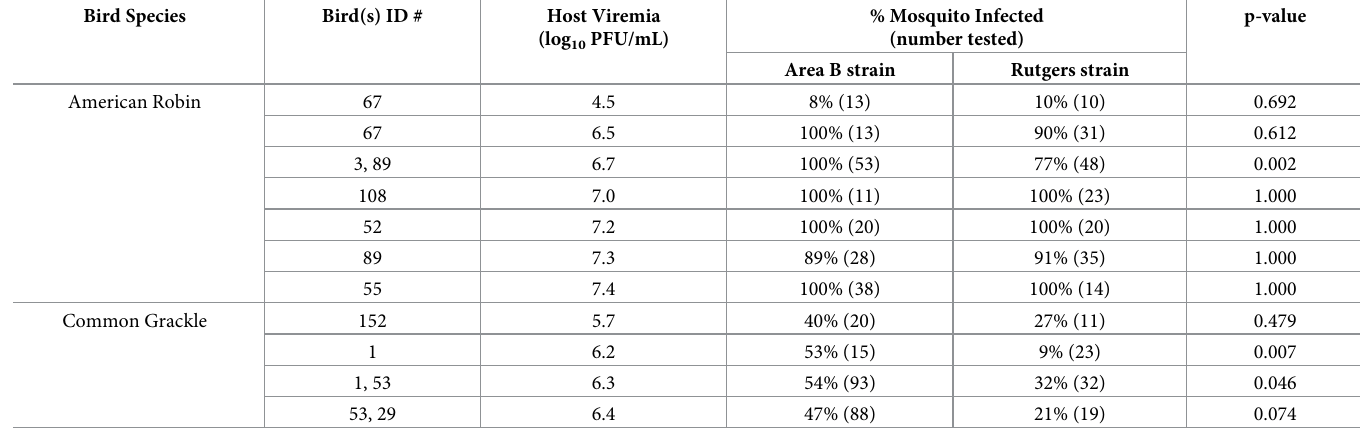
Table 1. West Nile virus infection rates in two strains of Culex pipiens mosquitoes 5 to 7 days after feeding concurrently on birds with the same viremia. Mosquito infection data are pooled in instances where two birds had the same viremia. Bird Species